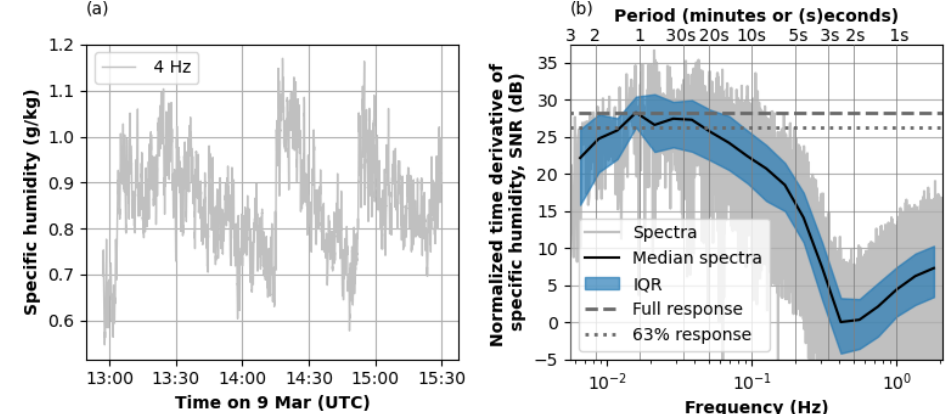
Figure 8. Inlet response determination for the profiling period on 9 March 2020, from 12:57 to 15:30UTC. (a) The 4Hz specific-humidity signal as measured by the analyzer. (b) The fast Fourier transform of the normalized time derivative of the specific humidity (gray), expressed as a signal-to-noise ratio. Black line is the median of the resulting power spectra across 20 logarithmically spaced bins between 5 . 55 × 10 − 3 and 2Hz, while colored shading is the IQR of the bin. The minimum of the median (at approximately 0.4Hz or 2.5s) serves as noise baseline, whereas the maximum signifies the full response (dashed gray line). Dotted line indicates 63% of the full